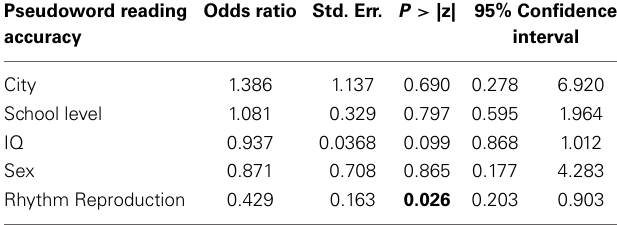
Table 6 | Logistic